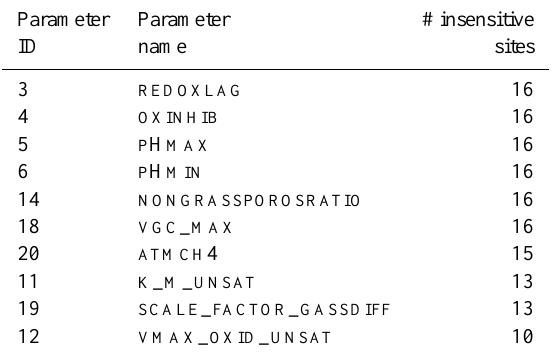
Table 2. Parameters that are sensitive for most observation sites (out of 16).